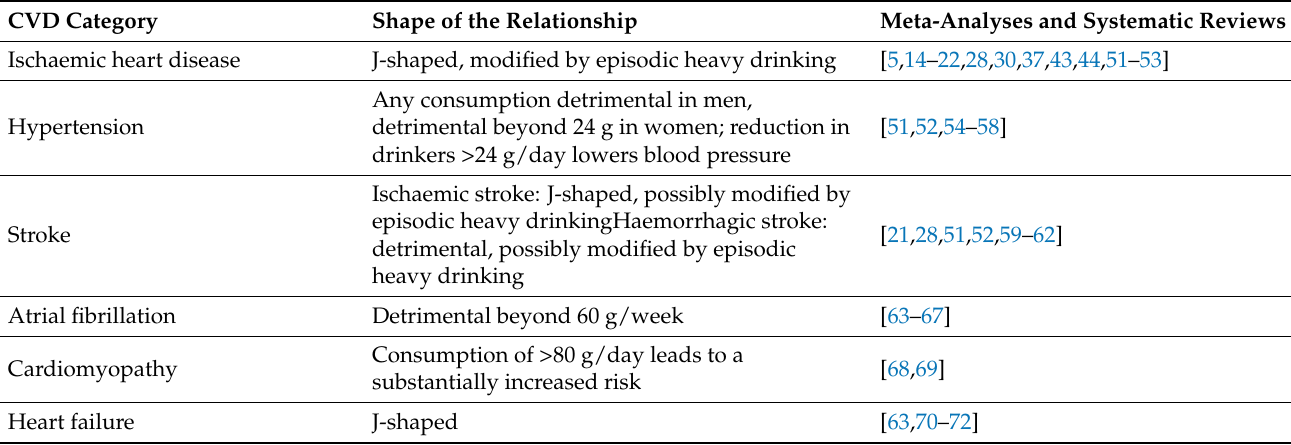
Table 1. Shape of the relation between alcohol consumption and CVD categories based on current evidence